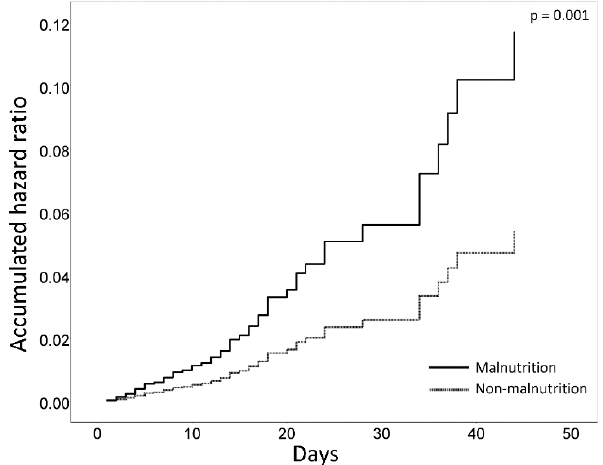
Figure 3. Accumulated hazard ratio over hospitalized days. The multivariate Cox regression model depicted a higher hazard ratio in malnourished patients (solid line) than in patients without malnutrition (dotted line, p =